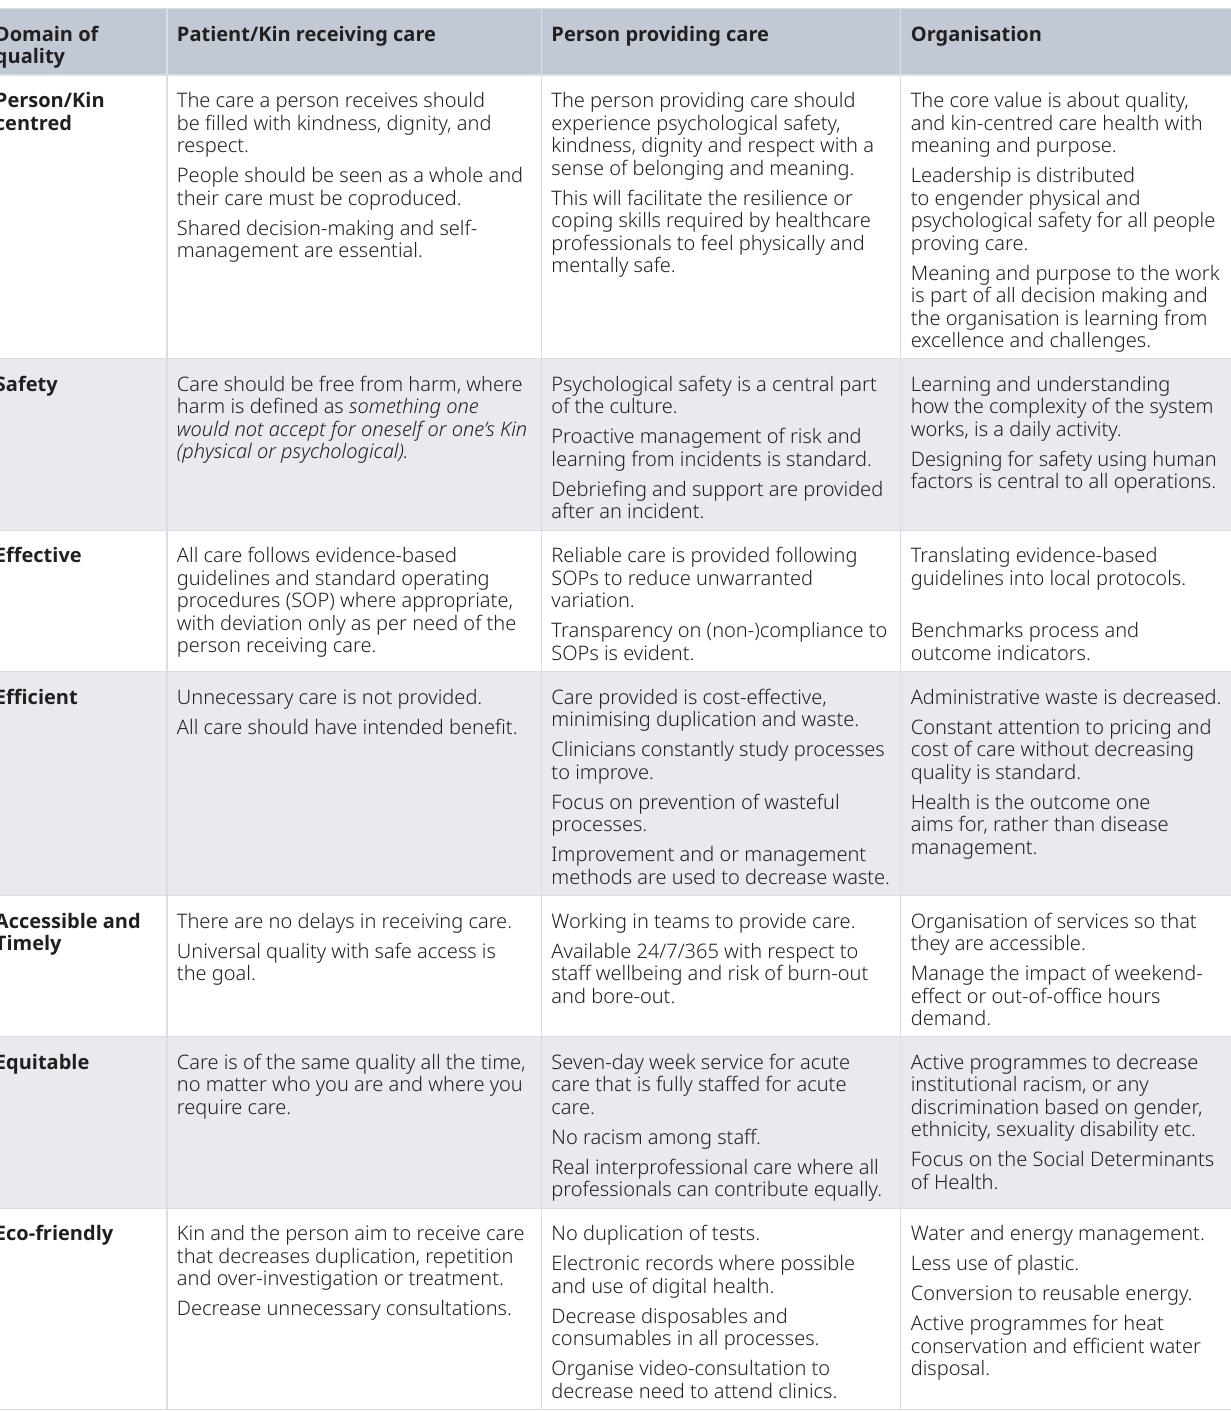
Table 3. The domains of quality and action to be